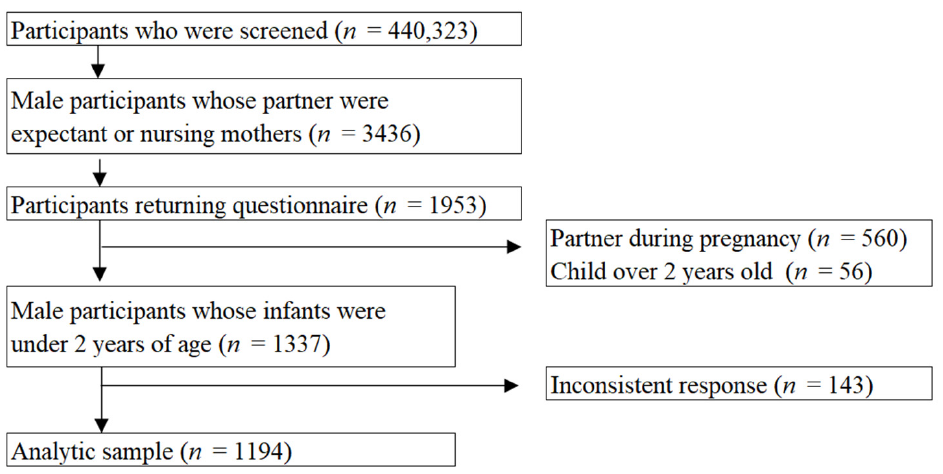
Figure 1. Sample flow chart.